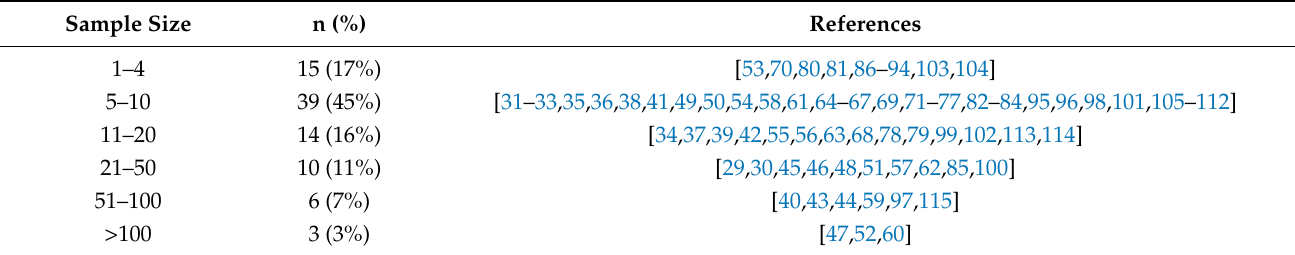
Table 3. Sample size of the included studies (n = 87).